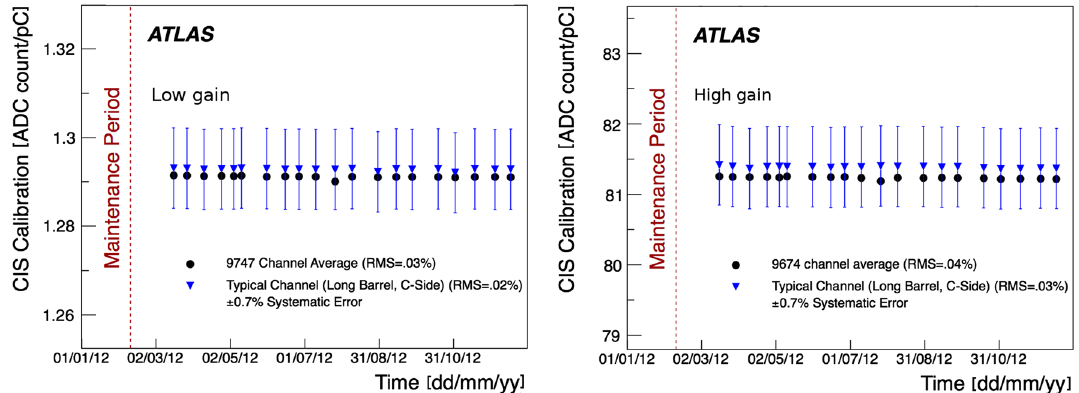
Fig. 16 Stability of the charge injection system constants for the low- gain ADCs (left) and high-gain ADCs (right) as a function of time in 2012. Values for the average over all channels and for one typical chan-